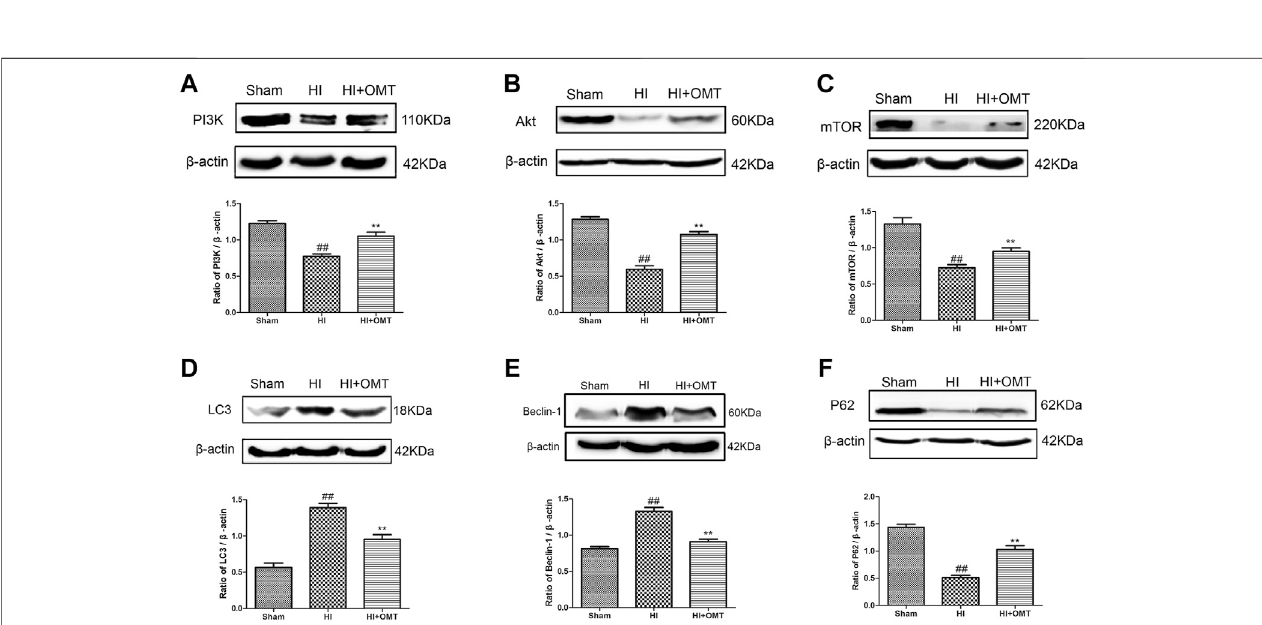
FIGURE 5 | Assessment of the protein expression levels of phosphatidylinositol 3-kinase (PI3K), protein kinase B (Akt), mammalian target of rapamycin (mTOR), LC3, Beclin-1 and P62 in the ischemic hemisphere in the neonatal rats at 48 h after hypoxia-ischemia brain damage (HIBD). Representative Western blots and quantitative analyses of the protein expression of (A) PI3K, (B) Akt, (C) mTOR, (D) LC3, (E) Beclin-1 (F) and P62. The results are expressed as means ± SEM ( n (cid:1) 6 per group). ## p < 0.01 vs. the sham group; and ** p < 0.01 vs. the HI group.